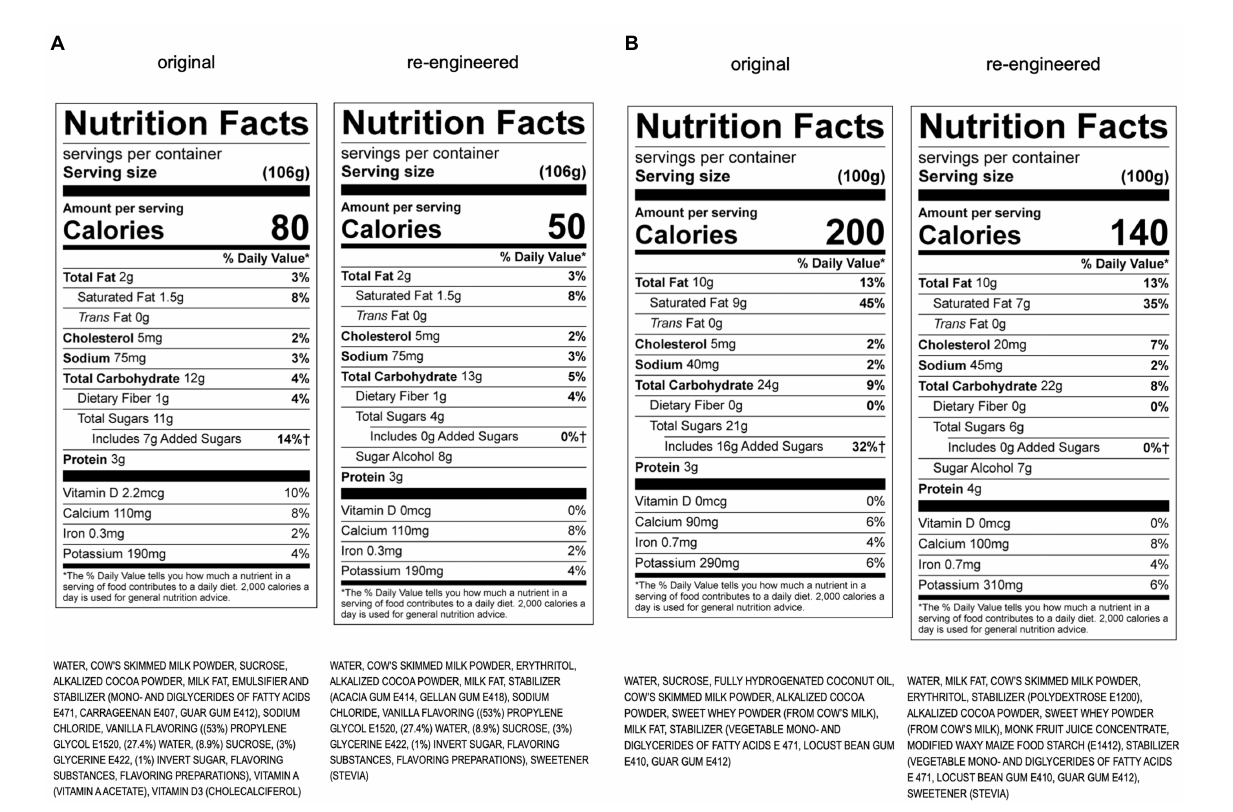
FIGURE 1 (A) Re-engineering of KDD chocolate milk using the Metabolic Matrix. (B) Re-engineering of KDD chocolate ice cream using the Metabolic